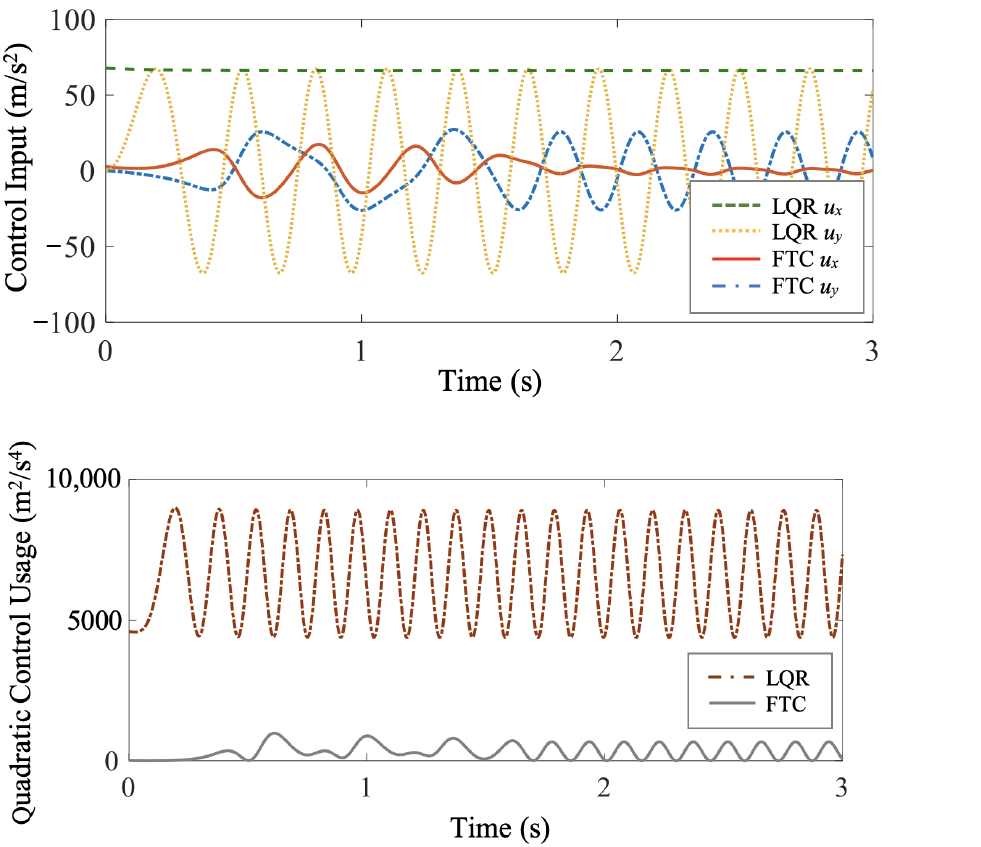
Figure 5. Case study 1: the comparison of the FTC and LQR control cost shows that the FTC-controlled vehicle meets the control objective with much less control effort than the LQR-controlled